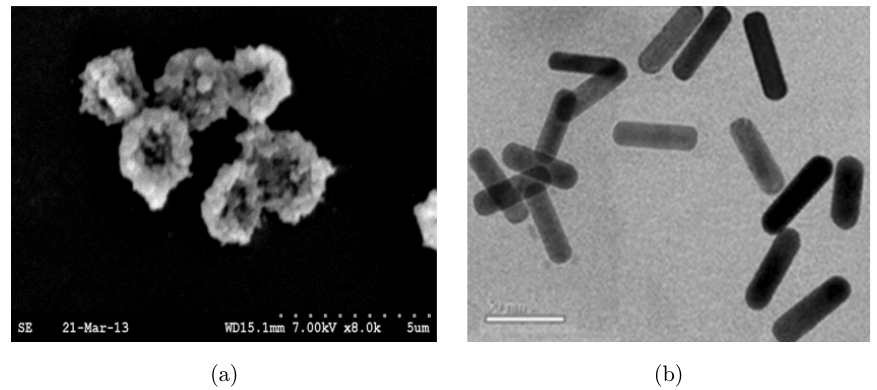
Fig. 2. (a) SEM image of hollow CaCO 3 microcapsules, (b) TEM image of Au